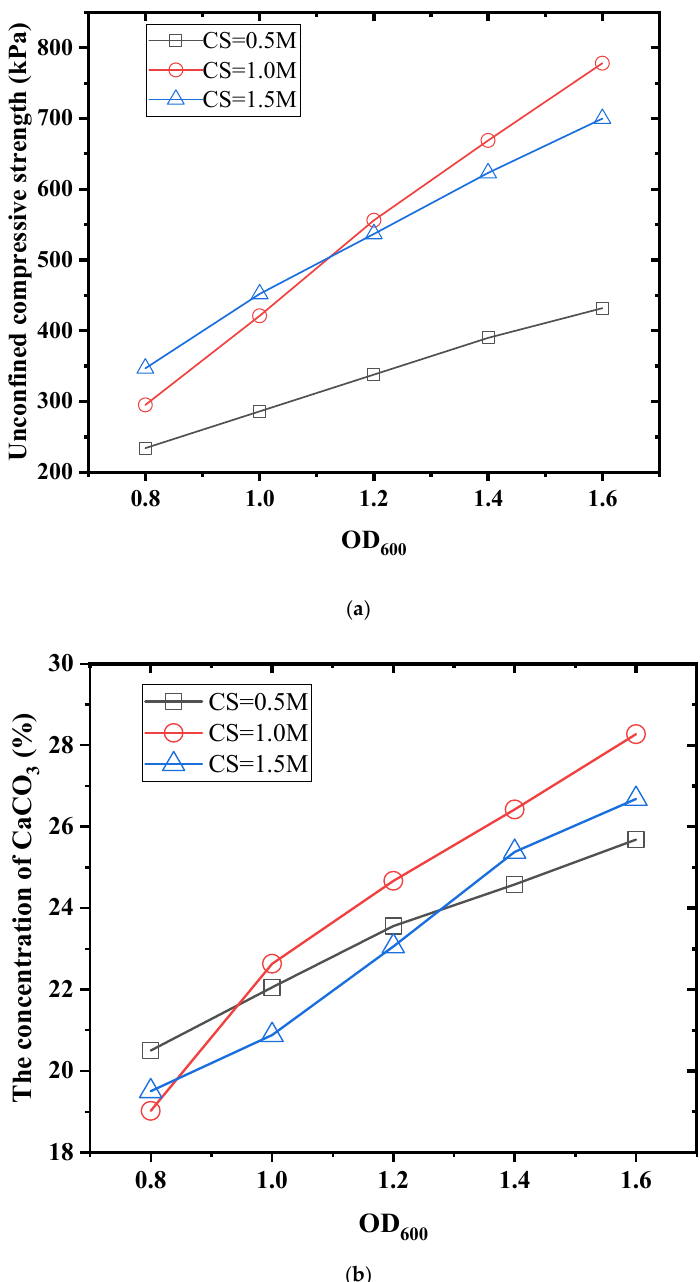
Figure 2. Test results of UCS and CaCO 3 concentration. ( a ) Unconfined Compressive Strength; ( b ) CaCO 3 Concentration.